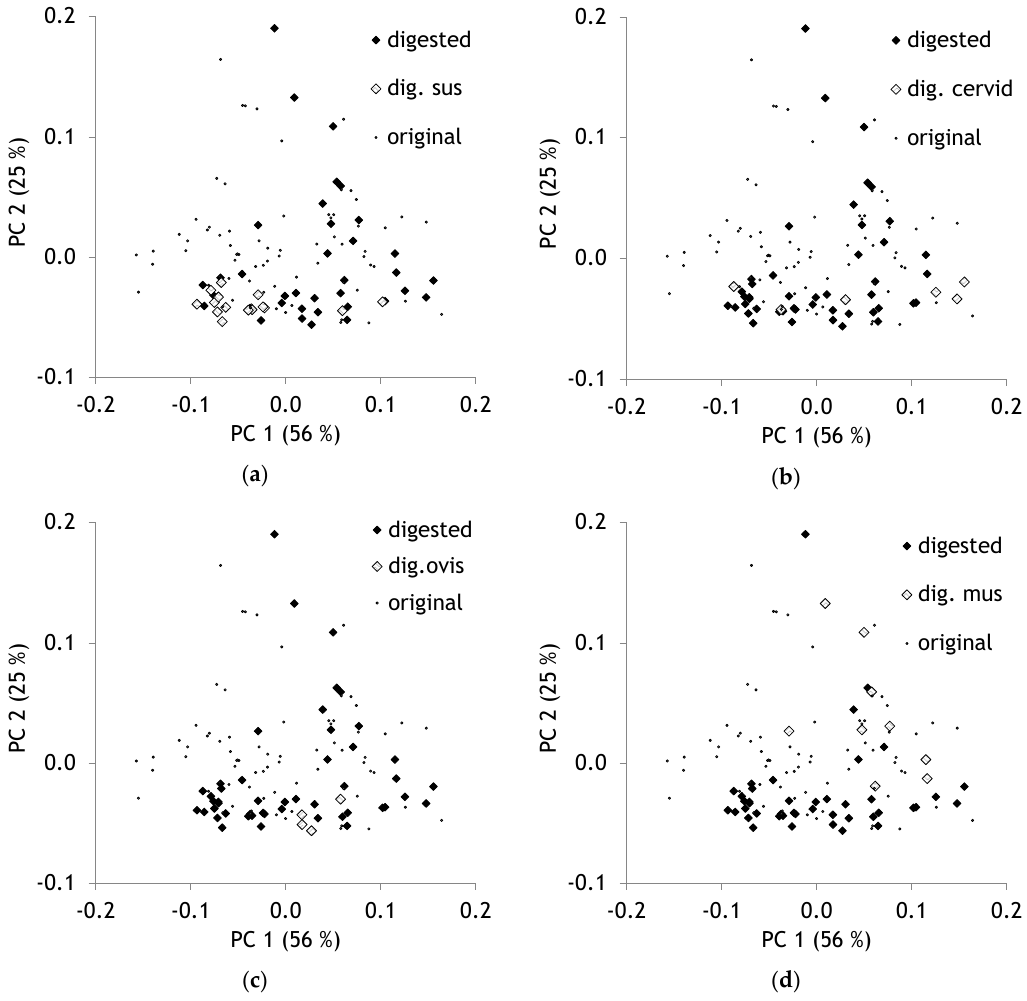
Figure 3. ( a ) Scores plot with highlighted samples of wild boar, ( b ) deer, ( c ) cats and dogs, ( d ) human hair, ( e ) and of bird feathers; ( f ) loadings plot of PCA containing only unground samples, n = 124.